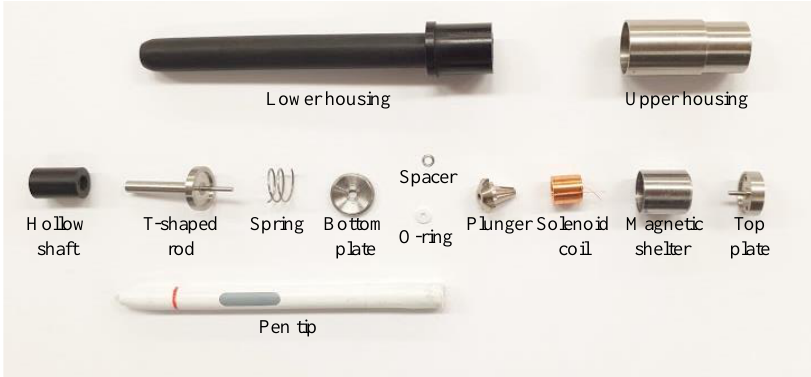
Figure 7. Components for the proposed tiny haptic stylus.